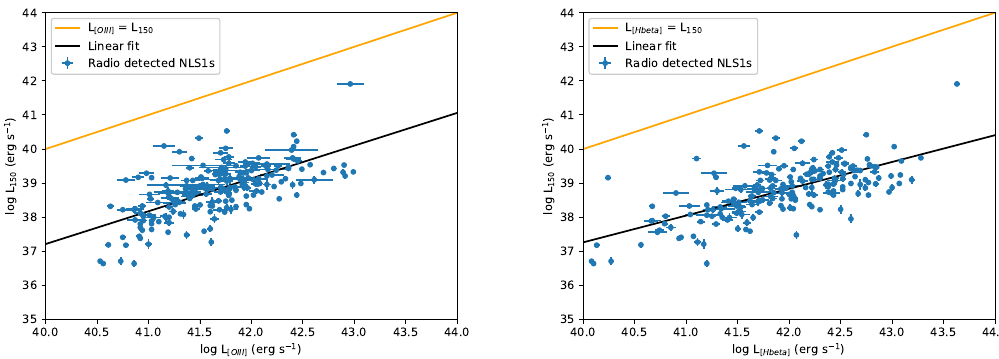
Figure 3. Left panel : The connection between [O III ] luminosity and 150 MHz radio luminosity. Right panel : The connection between the luminosity of broad H β and 150 MHz radio luminosity. The black solid lines show the best fits, while the orange solid lines represent the line where the two parameters are equal with each